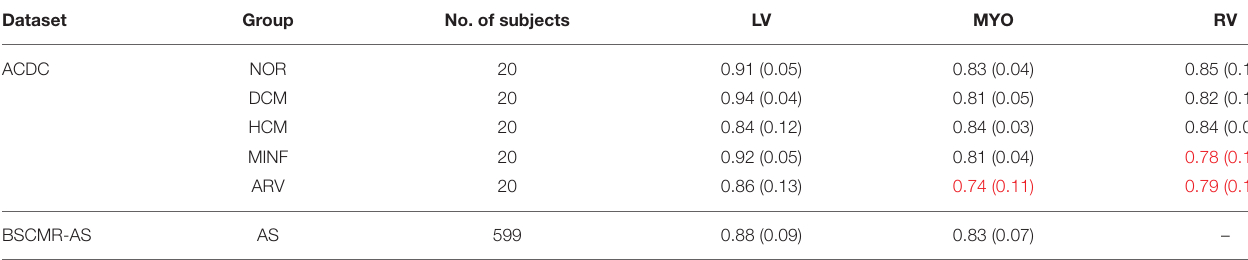
TABLE 8 | Segmentation performance of the UKBB model across the five groups of pathological cases and normal cases (NOR). Dataset